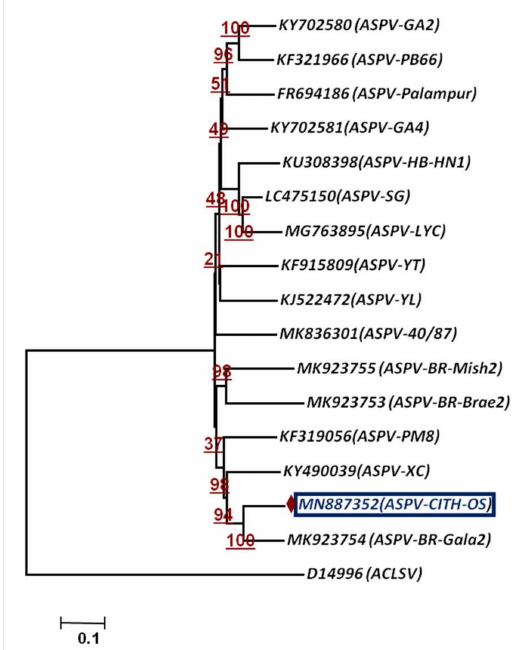
Figure 6. Phylogenetic relationship of apple stem pitting virus based on whole-genome sequence alignment through NJM at 1000 replications for each bootstrap value using MEGA 7.0; our ASPV isolate is highlighted with color in phylogeny. Apple chlorotic leaf spot virus (ACLSV) represents out-group.